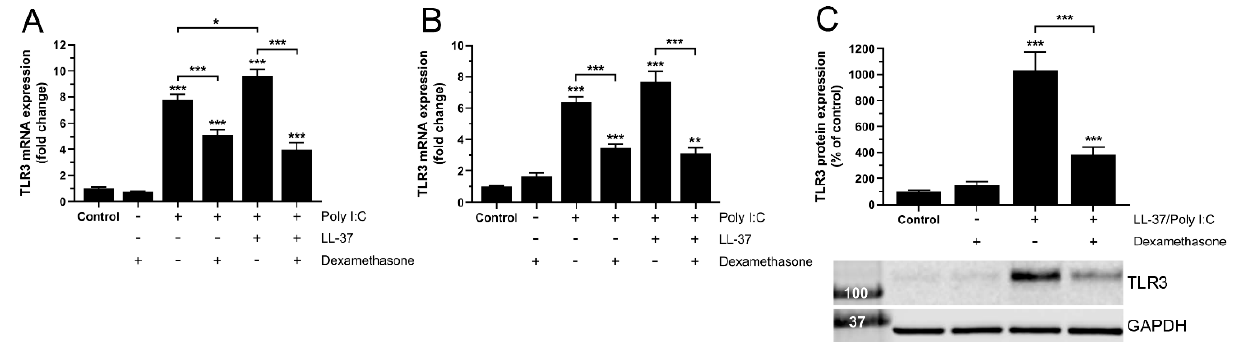
Figure 1. LL-37/poly I:C-induced stimulation of TLR3 expression is reduced by dexamethasone in BEAS-2B cells. ( A , B ) TLR3 mRNA expression was determined using quantitative real-time RT-PCR in cells treated with or without poly I:C (10 µg/mL) alone, or LL-37 (1 µM) and poly I:C (10 µg/mL) in combination in the presence or absence of dexamethasone (1 µM) for 6 h ( A ) and 24 h ( B ). ( C ) TLR3 protein expression was assessed using Western blot in cells treated with or without LL-37 (1 µM) and poly I:C (10 µg/mL) in combination (LL-37/poly I:C) in the presence or absence of dexamethasone (1 µM) for 24 h. The TLR3 immunoreactive band was observed at the expected molecular weight of 115–130 kDa and normalized to GAPDH (37 kDa), serving as internal control. ( A – C ) Data are presented as mean ± SEM, n = 7–8 ( A , B ) and n = 6 ( C ) in each group. Statistical significance was calculated using a one-way ANOVA, followed by Tukey’s post hoc test. ** and *** represent p < 0.01 and p < 0.001, respectively, vs. control. For comparisons indicated by the bars, * and *** represent p < 0.05 and p < 0.001, respectively.